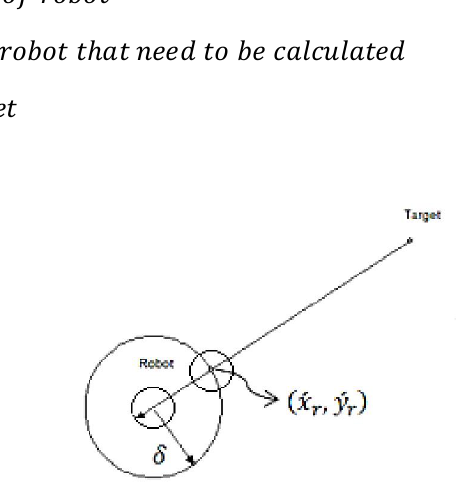
Fig. 1. Current location of robot and finding its next